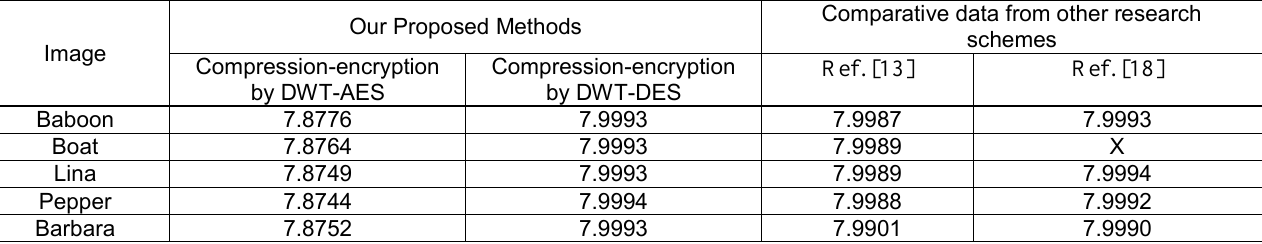
Comparative data from other research